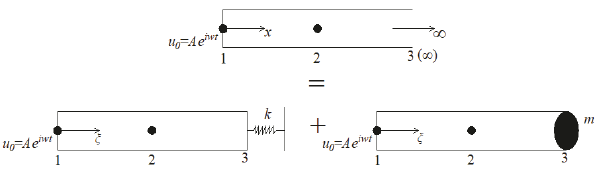
Figure 3: Dynamic mapping of a 1D infinite